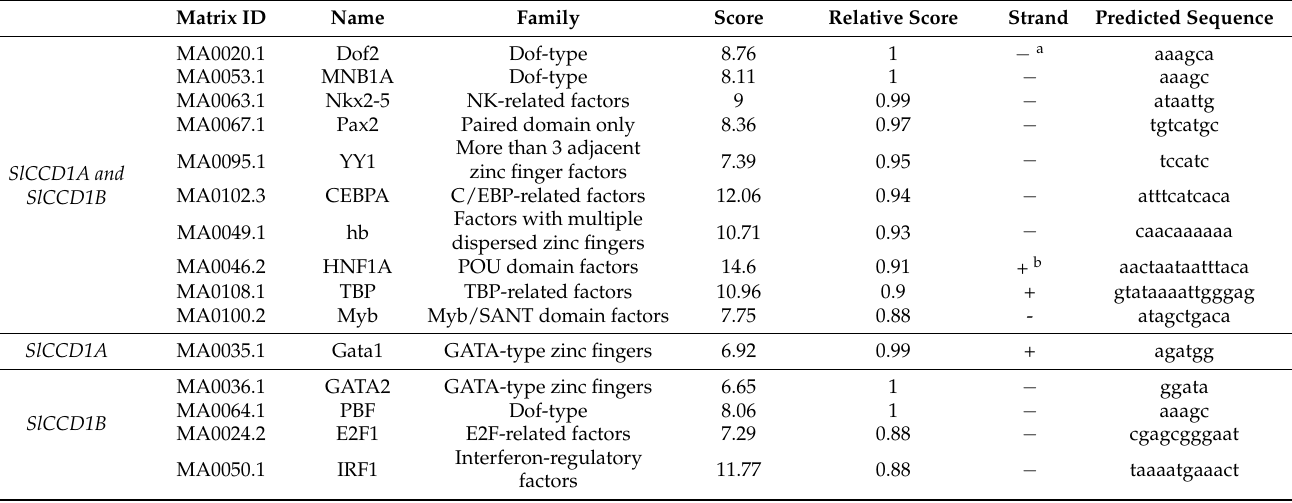
Table 1. Predictions of the transcription factors regulating the promoters of SlCCD1A and SlCCD1B in